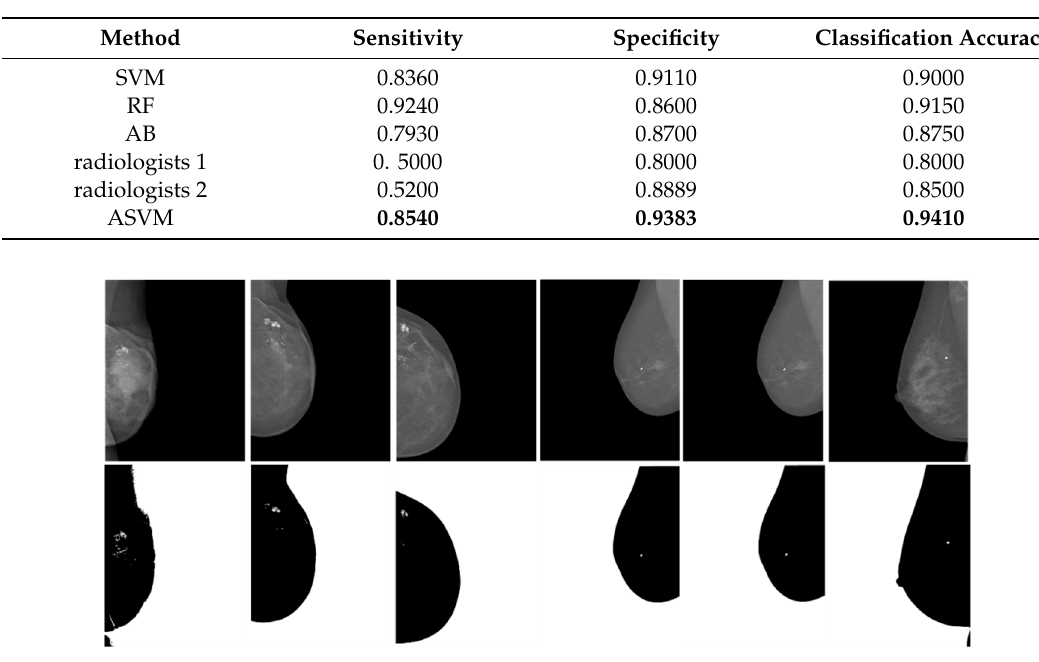
Table 3. Comparison of calcification test results.